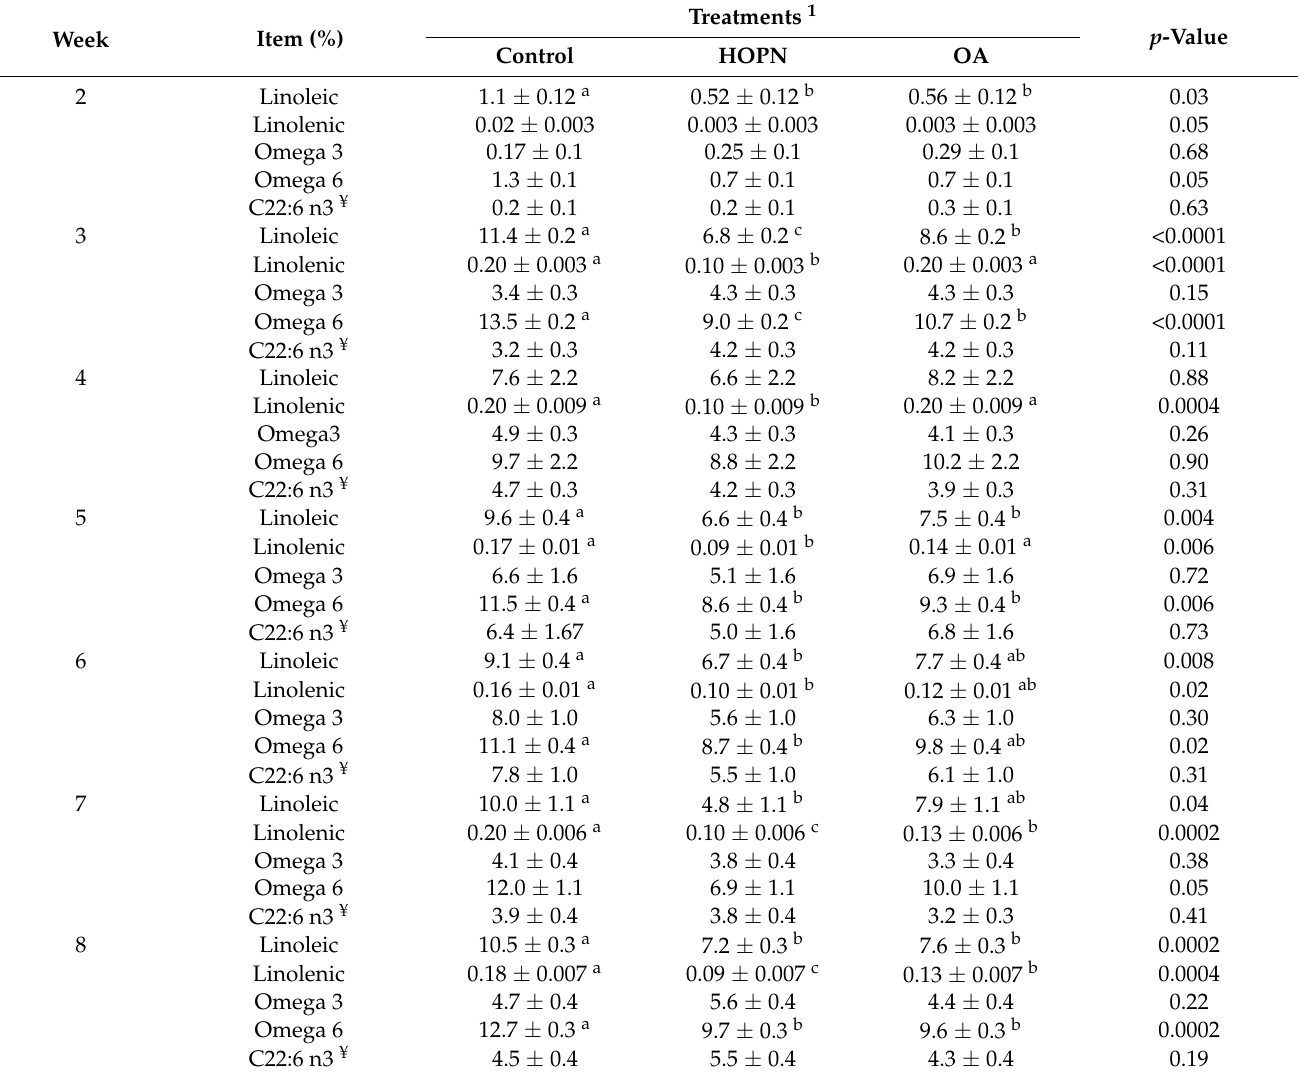
Table 6. The effect of feeding laying hens a high-oleic peanut (HOPN) diet or an oleic fatty acid (OA) diet on the unsaturated fatty acid profile of the eggs